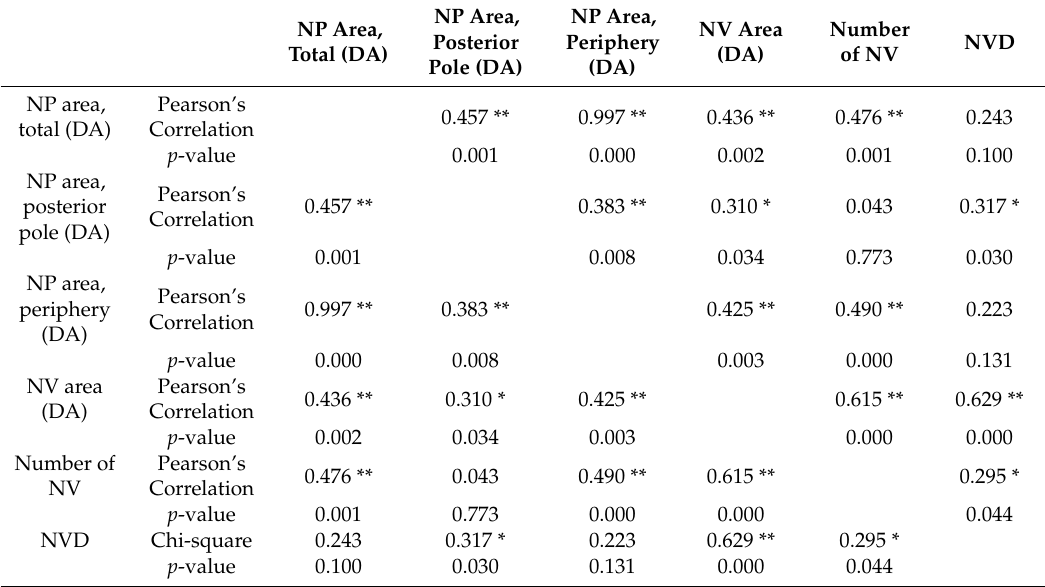
Table 3. Correlation among nonperfusion areas, NV areas, and numbers.